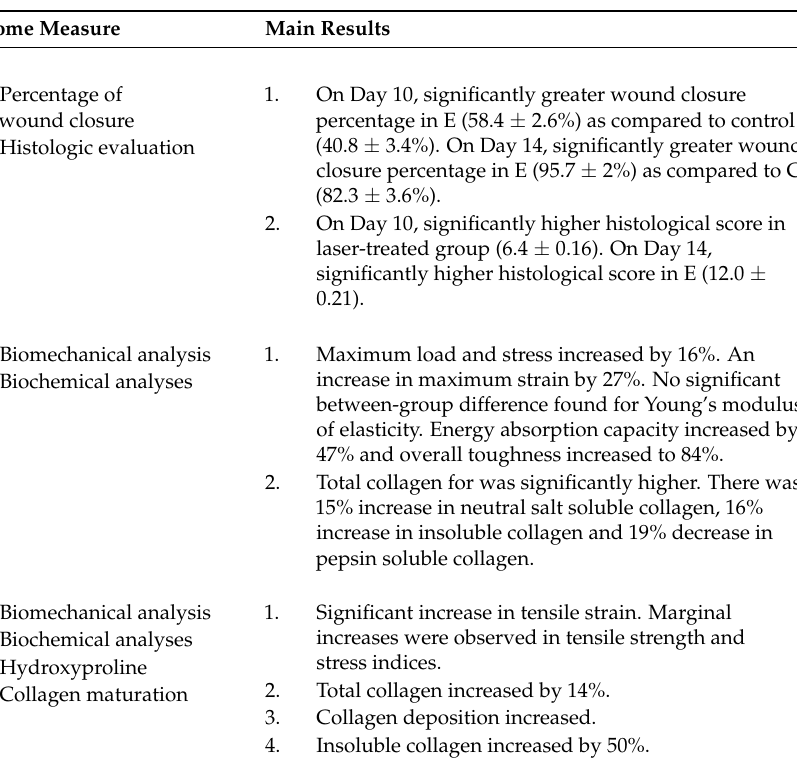
Table 5. Outcomes of in vivo studies on photo energies (PE) for treating diabetic